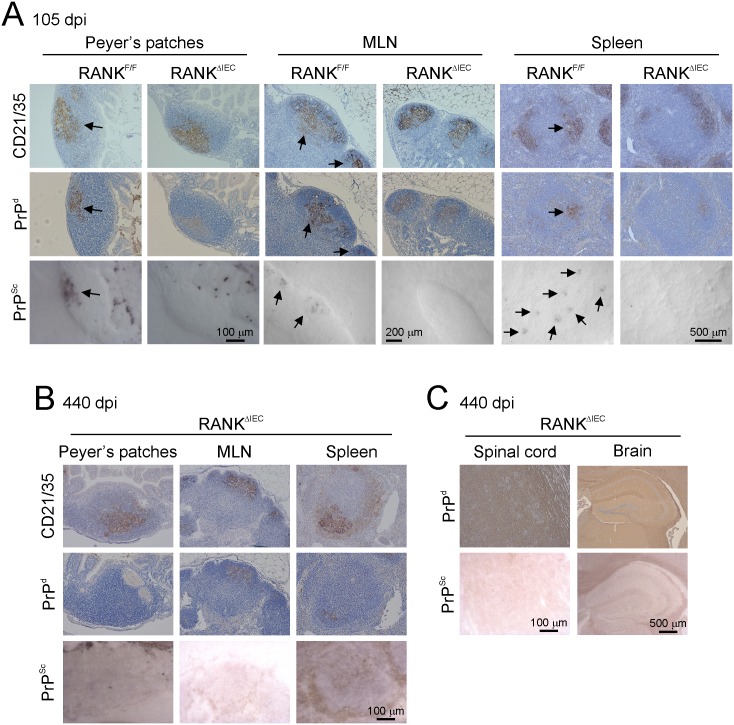
PrPSc accumulation upon follicular dendritic cells (FDC) after oral prion exposure is blocked in RANKΔIEC mice.In order to determine the effect of specific M cell-deficiency on oral prion pathogenesis, RANKΔIEC mice and RANKF/F (control) mice were orally-exposed to a 1% dose of ME7 scrapie prions and tissues collected at intervals afterwards. At 105 d post infection (dpi) high levels of disease-specific PrP (PrPd, brown, middle rows) were detected in association with FDC (CD21/35+ cells, brown, upper panels) in (A) the Peyer’s patches, (B) mesenteric lymph nodes (MLN), and (C) spleens of RANKF/F control mice. Analysis of adjacent sections by PET immunoblot analysis confirmed the presence of prion-specific PK-resistant PrPSc (blue/black). Arrows show PrPd/PrPSc accumulation upon FDC networks. In contrast, no PrPSc was detected in any of the Peyer’s patches, MLN and spleens from orally-exposed RANKΔIEC mice at (A) 105 dpi or (B) 440 dpi. C) Similarly, no PrPSc was detected in any of the spinal cords or brains of orally-exposed RANKΔIEC mice at 440 dpi. Sections were counterstained with haematoxylin to detect cell nuclei (blue). Images are representative of 8 orally-exposed RANKΔIEC mice.